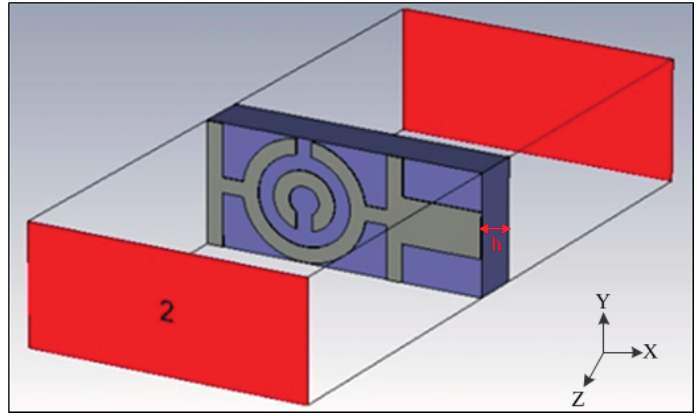
Figure 2. Simulation geometry of the proposed unit